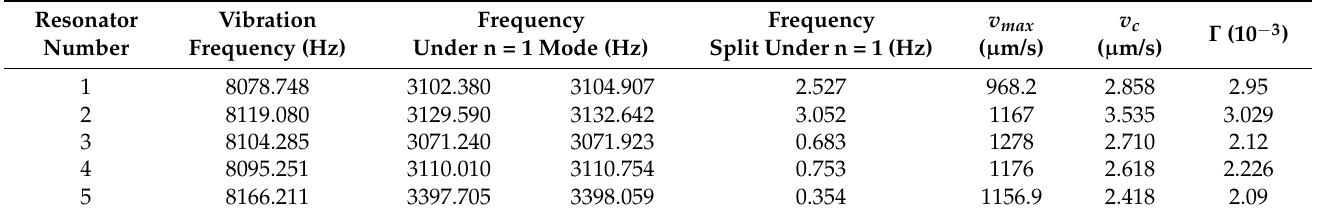
Table 2. Vibration frequency, frequency split under n = 1 mode, and coefficient of harmonic vibration of experimental resonators.